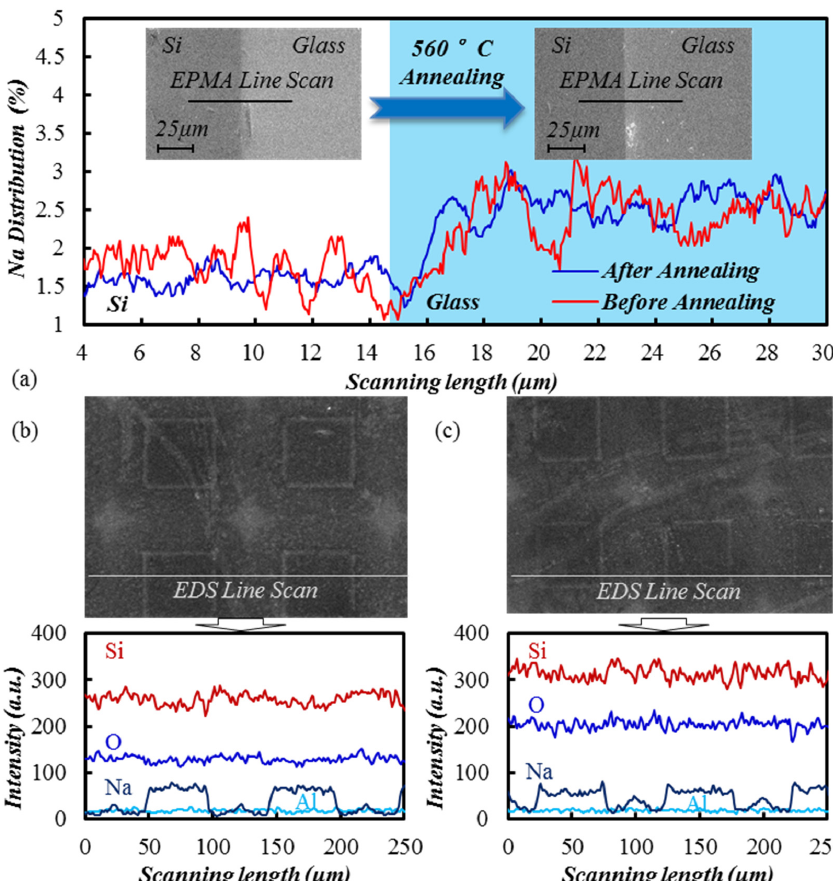
Figure 15. Electron probe micro-analyzer and energy dispersive spectroscopy (EDS) line scan for element distribution, ( a ) bonding joint with 360 ◦ C, 1200 V; ( b ) TEM glass using 50 µ m square groove mould with 380 ◦ C, 600 V; ( c ) TEM glass with 560 ◦ C, 6 h post-annealing.